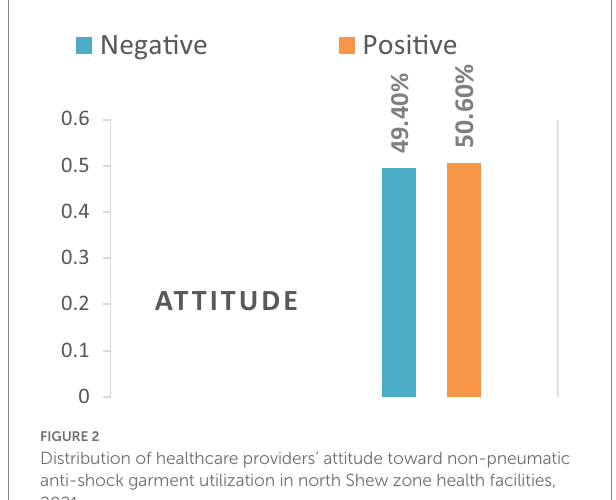
FIGURE 2 Distribution of healthcare providers’ attitude toward non-pneumatic anti-shock garment utilization in north Shew zone health facilities,